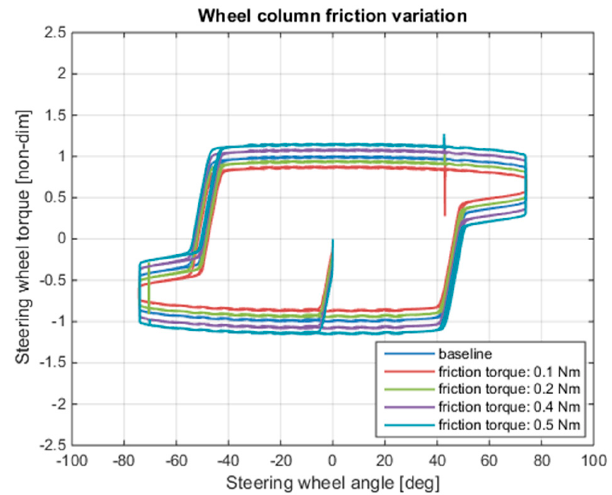
Figure 15. Steering wheel torque-angle curve for different values of friction at the wheel column.